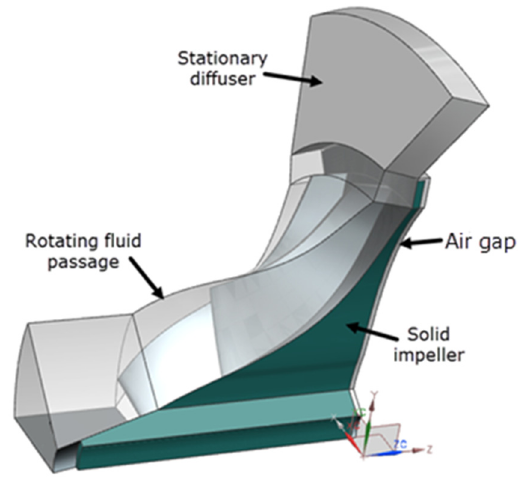
Figure 2. Computational domain for the Figure 2 . Computational domain for the compressor.